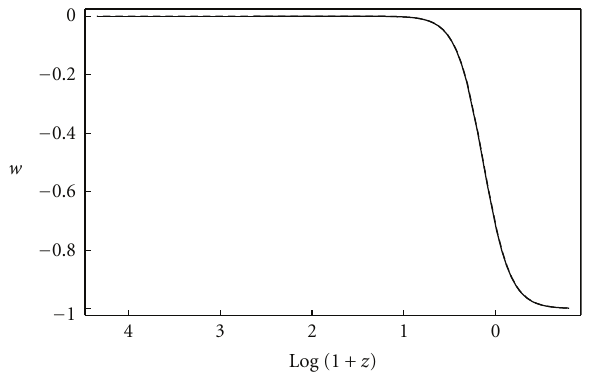
Figure 3: The redshift evolution of the scalar field equation of state parameter w UDM (continuous line) is compared with that of the sum of the DM + DE components in a standard Λ CDM model (dashed line); see [33].